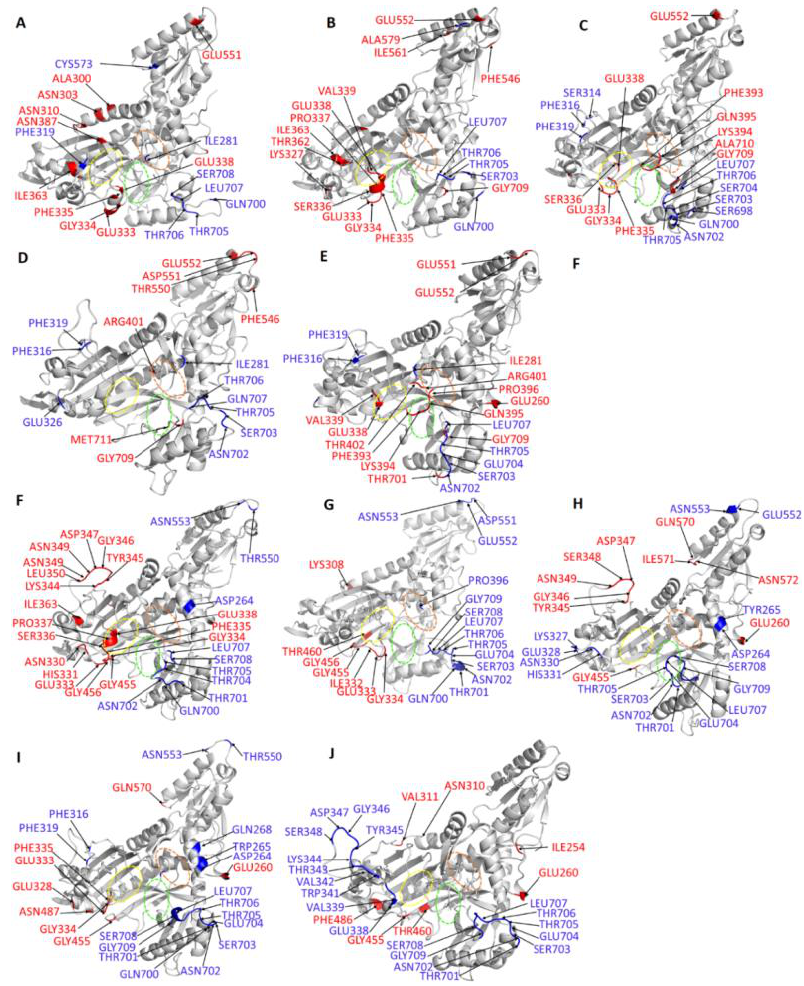
Figure 11. Cartoon representation of PfProRS homology model showing structural mapping of residues with significant ∆ L (2 standard deviations). ∆ L values were calculated by taking the L value of the holo protein less the ligand-bound complex. Structures were obtained at 200 ns of the MD simulations. Residues with negative ∆ L values are shown in blue while residues with positive ∆ L values are shown in red. The active site is shown in green ellipses, ATP binding site in yellow ellipses and the predicted allosteric site in orange ellipses. ( A ) PfProRS-SANC152 complex, ( B ) PfProRS-SANC235 complex, ( C ) PfProRS-SANC236 complex, ( D ) PfProRS-SANC244 complex, ( E ) PfProRS-SANC318 complex ( F ) PfProRS-SANC184 complex, ( G ) PfProRS-SANC257 complex, ( H ), PfProRS-SANC264 complex, ( I ) PfProRS-SANC456 complex and ( J ) PfProRS-SANC622